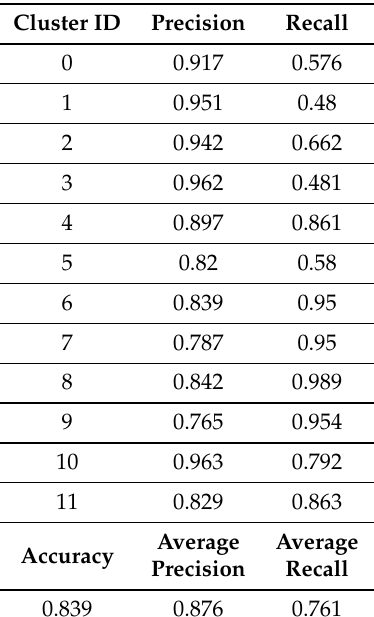
Figure 16. Grid-search for K-NN algorithm: ( a ) accuracy considering all the variables; and ( b ) accuracy considering only geometric variables. Table 5. Metrics with all the